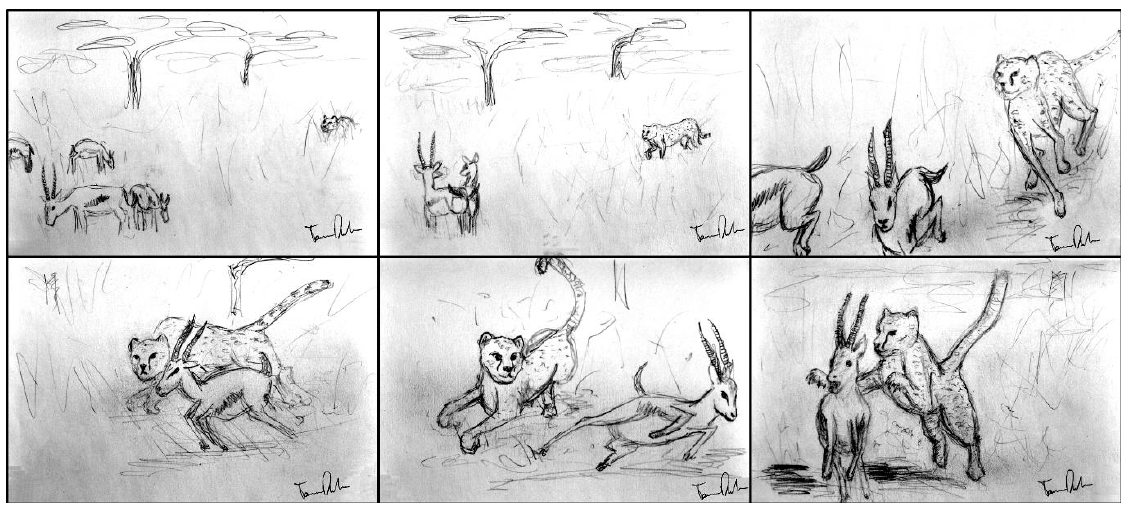
Figure 1 . A cheetah hunting a gazelle and the gazelle running for its life. [Drawing by Tommaso